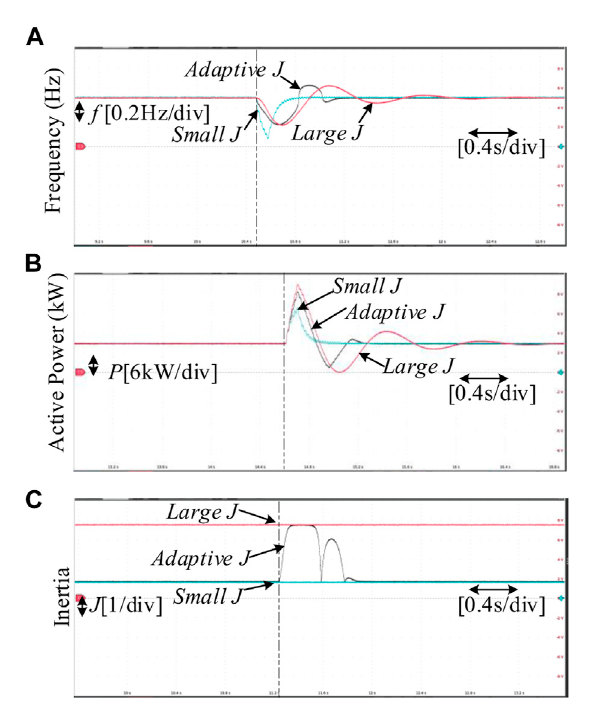
FIGURE 11 Experimental results of Scenario 2. (A) Frequency of GFM inverter. (B) Active power of GFM inverter. (C) Inertia of GFM inverter.